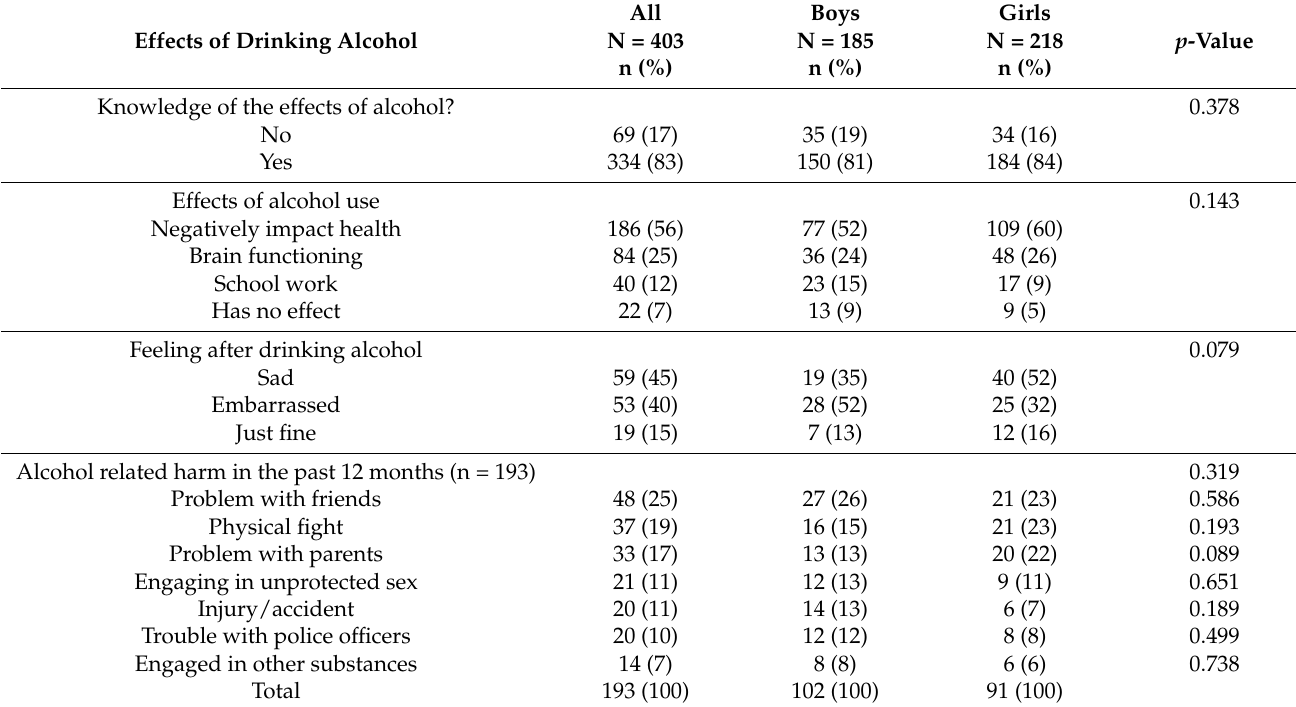
Table 4. Effects of alcohol use among school